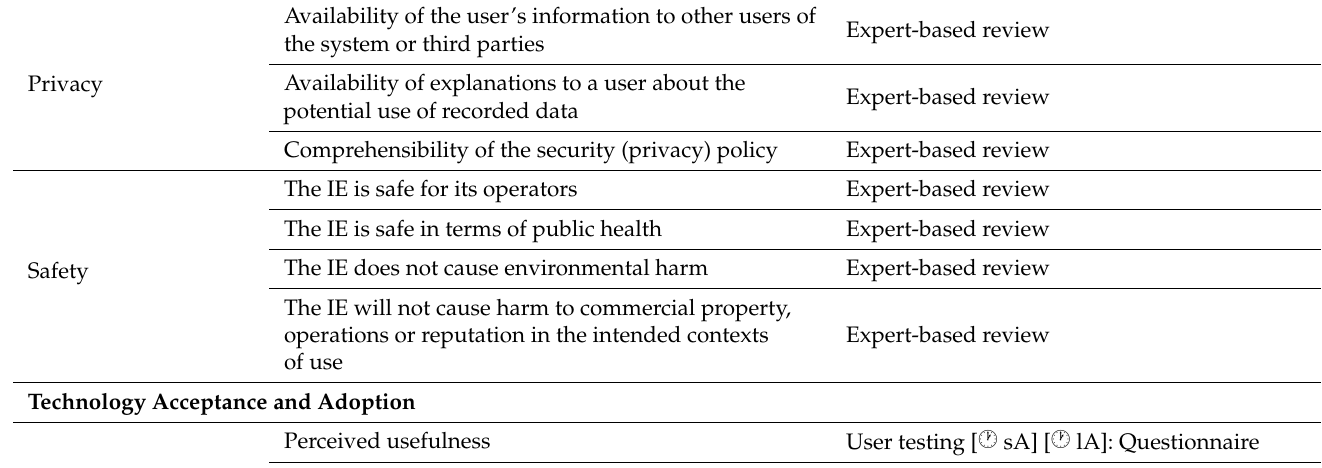
Table 1. The UXIE framework: concepts, attributes, metrics and methods. Asterisk (*) denotes metrics that are novel in the UXIE framework.